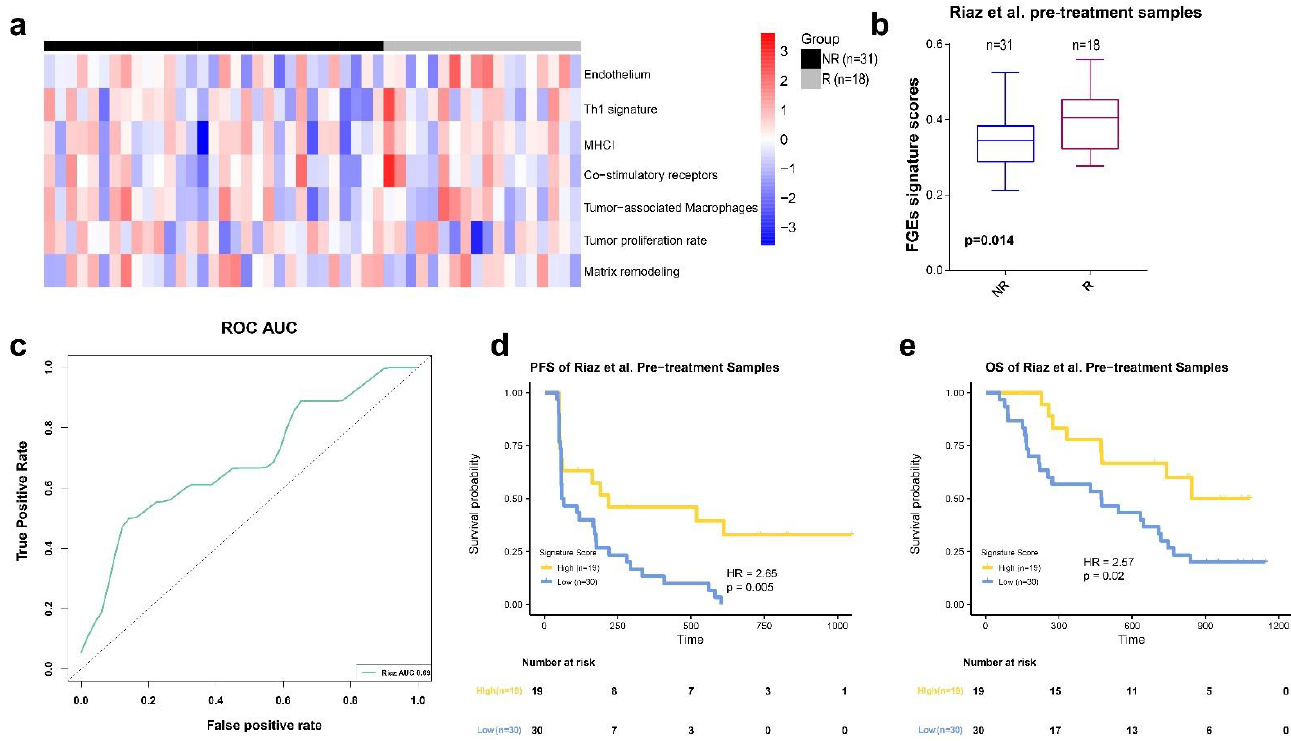
Figure 2. FGE-based signature for pretreatment samples (FGE-PRE). ( a ) Heatmap representing the single sample gene set enrichment analysis value of pretreatment nonresponders (NR) and responders (R) in the Riaz et al. cohort. ( b ) Boxplot of FGE-PRE signature scores for pretreatment samples from the Riaz et al. datasets. p values were computed via a one-sided Wilcoxon rank-sum test. ( c ) Receiver operating correlation curve and area under the curve of FGE-PRE signatures for pretreatment samples from the Riaz et al. cohort. ( d , e ) Kaplan–Meier curves of PFS and overall survival for pretreatment samples based on FGE-PRE signature scores for the Riaz et al. cohort.